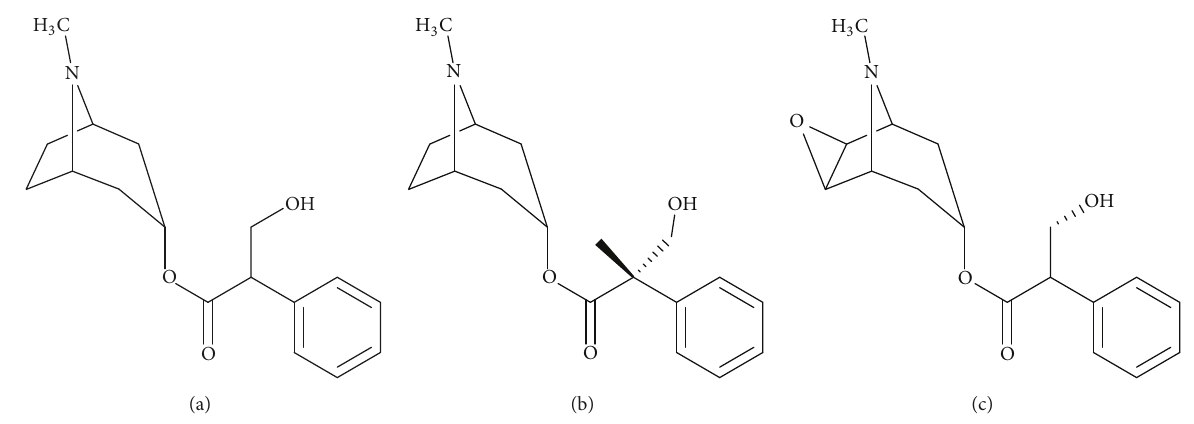
Figure 6: The main alkaloids of Datura stramonium L. [17,